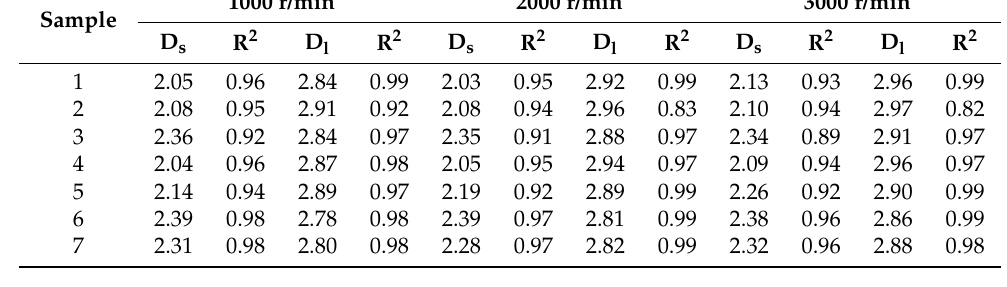
Figure 9. Plot of lg(f r ) versus Lg( T 2 ) using NMR from Sample 5. ( A ) the residual water distribution; ( B ) fractal curve of the residual water. Table 5. Fractal Dimensions of the residual water from NMR in different centrifugal speeds. Sample